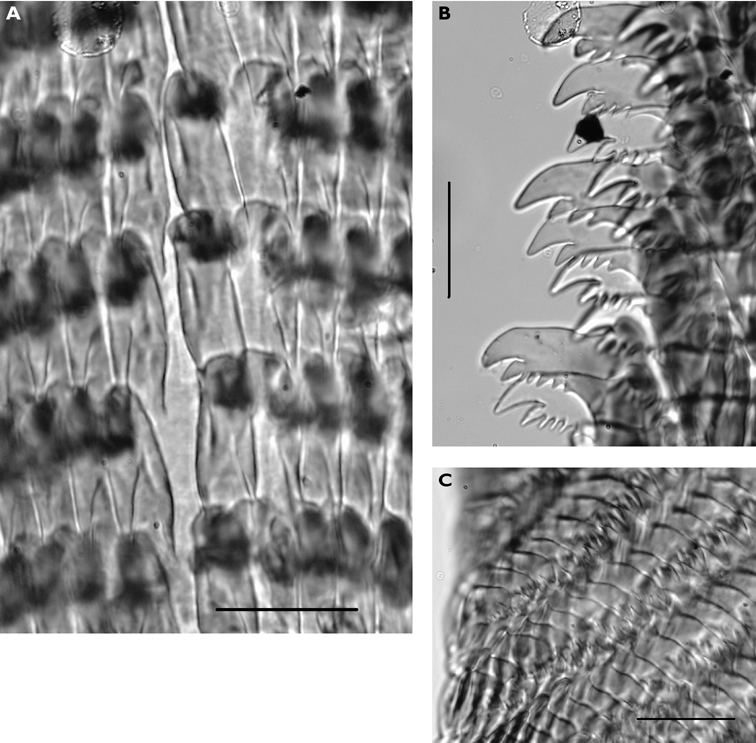
Risbecia pulchella, 50 mm A first 3–5 laterals on both sides of the midline, no central thickening or rhachidian B mid-lateral teeth showing single main cusp and divided first denticle C outermost laterals in newish row with reduction in cusp. Scale bars 50 µm.